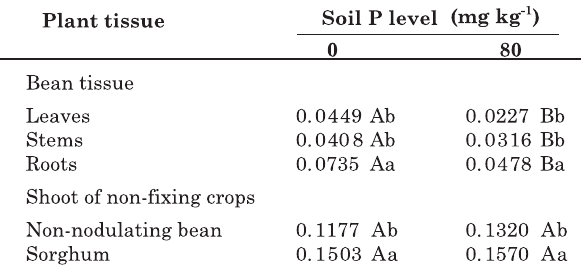
Lowercase letters compare plant parts in columns (within bean tissue or non-fixing crops), and capital letters compare soil P levels in lines; means followed by the same letter did not differ by t test at 0.05